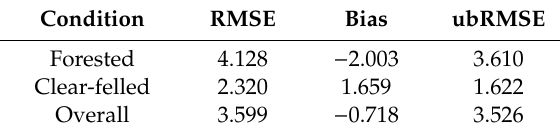
Figure 13. Time series of the ground CRNS soil water content estimates using the conventional and N 0 –neutron ratio approaches in the Two-Streams Catchment from January 2017 to August 2018. The root mean squared error (RMSE), bias, and unbiased root mean square error (ubRMSE) were determined for the soil water content estimates determined by the N 0 –neutron ration approach against the conventional calibration approach scenarios (forested, clear-felled, and both) (Table 3). The N 0 –neutron ratio approach has a lower RMSE (2.320), bias (1.659), and ubRMSE (1.622) for the clear-felled conditions compared to the forested conditions (RMSE (4.128), bias ( − 2.003), ubRMSE (3.610)). Table 3. Error metrics of the N 0 –neutron ratio